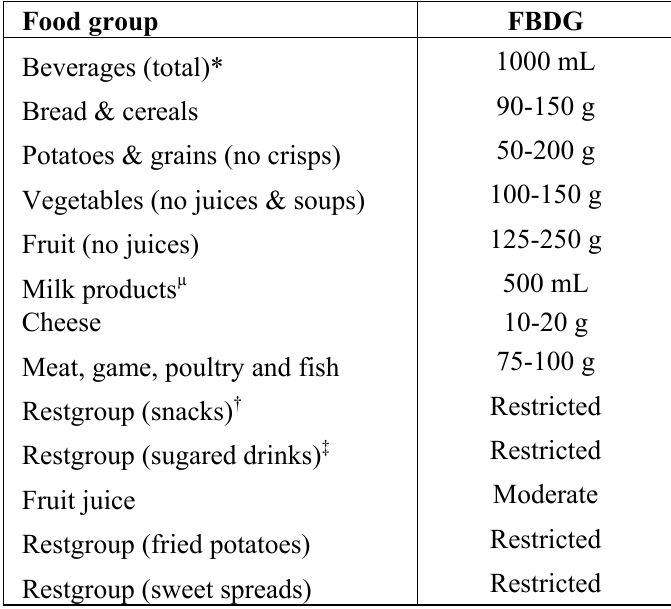
Table 1. Food based dietary guidelines